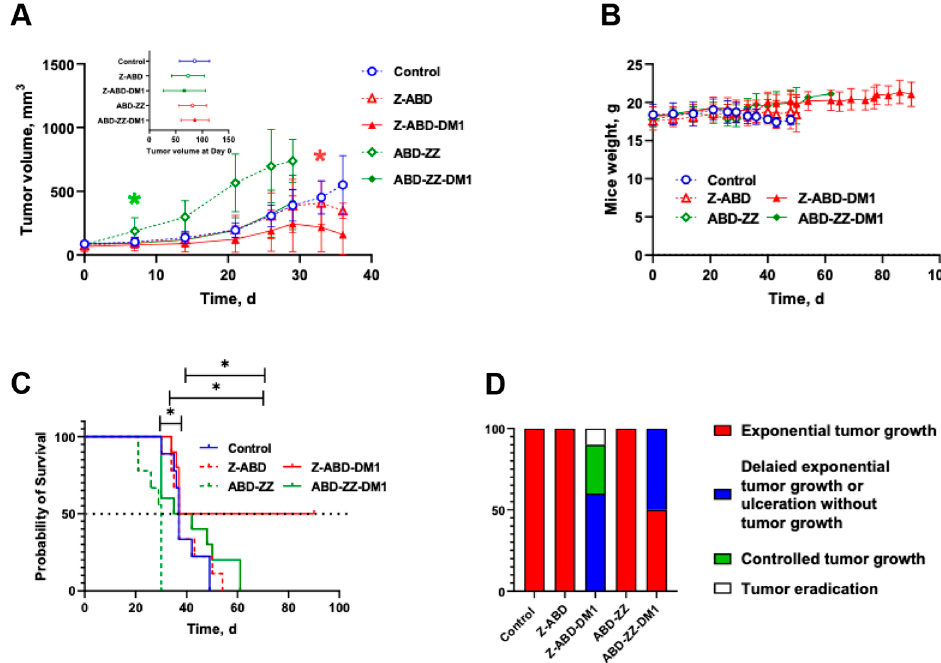
Figure 6. In vivo experimental therapy using Z-ABD-mcDM1, ABD-Z-Z-mcDM1, and the controls Z-ABD, ABD-Z-Z , and BSA in PBS. Treatment was started at day 0 and continued weekly for 10 weeks or to the humane end point (xenograft volume over 1 cm 3 or tumor ulcerated). ( A ) The average tumor volume of each group as a function of time ± SD. Curves were stopped when 30–33% of the mice in a group were euthanized. ( B ) The average mice weight in groups as a function of time ± SD. ( C ) The survival until euthanasia criteria of the xenografted mice. ( D ) The therapy output. * corresponds to significant difference ( p < 0.05)